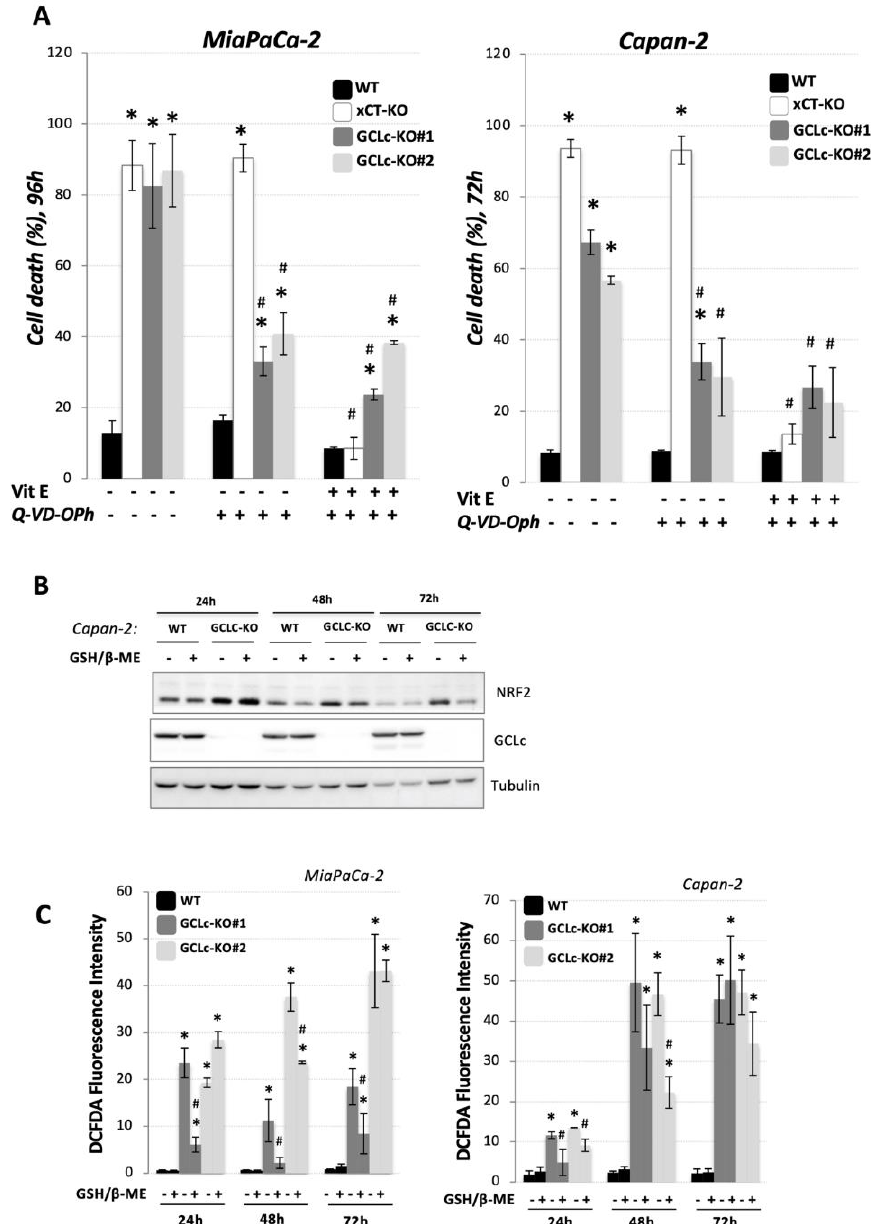
Figure 3. Glutathione depletion per se , leads preferentially to apoptosis in PDAC cells. ( A ). Cell viability was measured using PI staining method (see Material & Methods). Cells were seeded in media supplemented or not with ferroptosis inhibitor (10 µ M Vit E), apoptosis inhibitor (20 µ M Q-VD-Oph) or their combination, and cell viability was analyzed after 72 h (for Capan-2), i.e., 96 h (for MiaPaCa-2). xCT-KO cells were used as ferroptotic positive control ( white bars ) based on our previously published data (see the text). These results present mean ± SEM, n = 3. * p < 0.05, comparison with WT cells in control conditions; # p < 0.05, comparison with corresponding cell line in control conditions. ( B ). Protein content of a major sensor of oxidative stress (nuclear factor (erythroid-derived 2)-like 2 or NRF2) was analyzed in Capan-2 WT and GCLc-KO cells seeded in standard DMEM media supplemented or not with 3 mM GSH + 100 µ M β -ME, after 24, 48 and 72 h. Blots are representative of three independent experiments. ( C ). Intracellular ROS level was measured by staining with DCFDA (see Material & Methods) in WT and GCLc-KO cells of two PDAC cell line 24, 48 and 72 h after seeding in media supplemented or not with 3 mM GSH + 100 µ M β -ME. The results are presented as mean ± SEM, n = 3. * p < 0.05, comparison with corresponding WT control; # p < 0.05, comparison with corresponding cell line in control conditions.